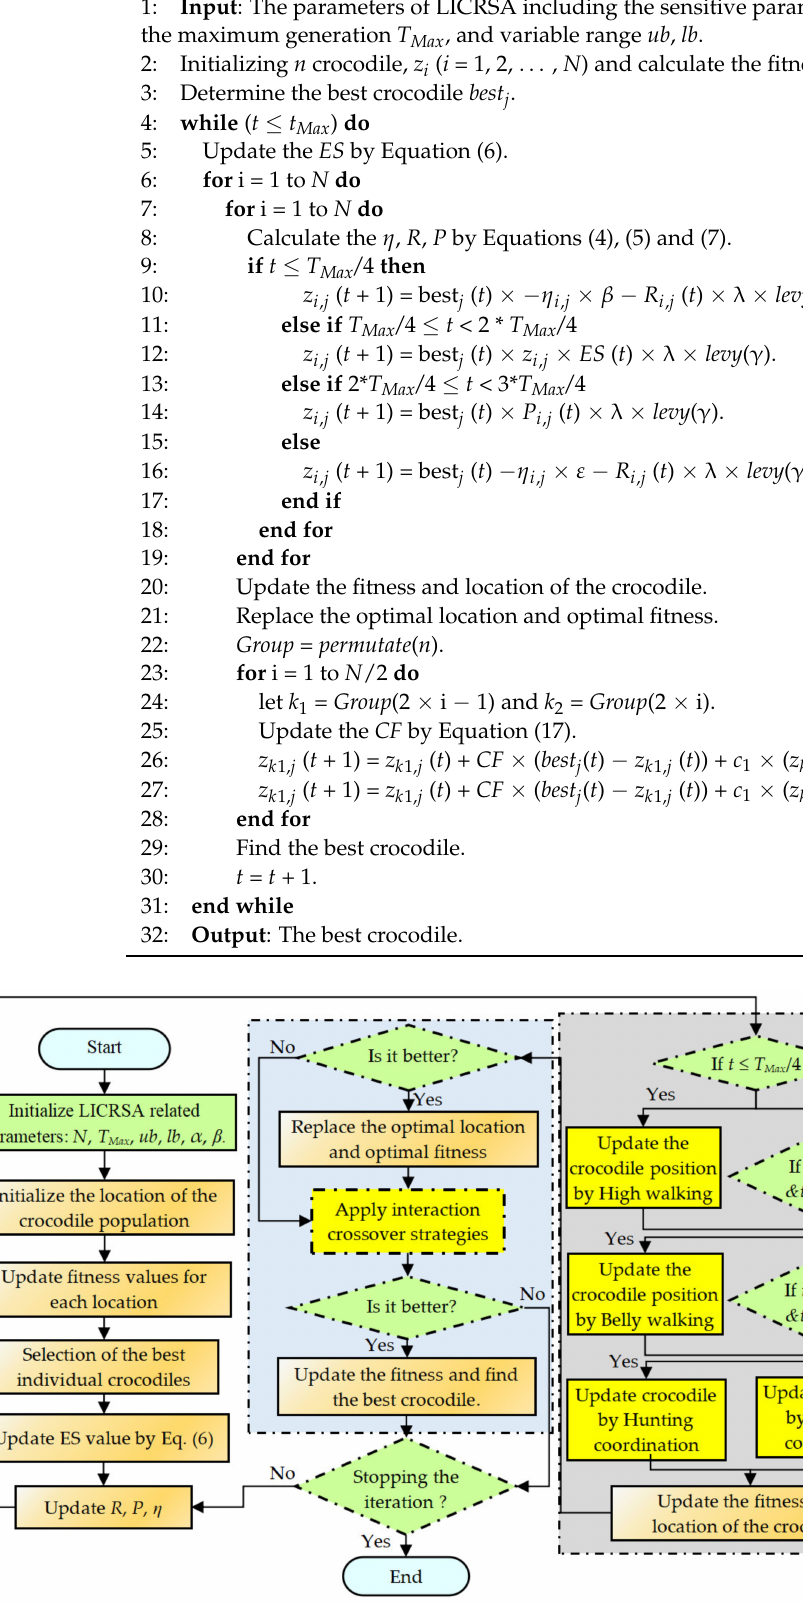
Figure 2. Flowchart for the LICRSA